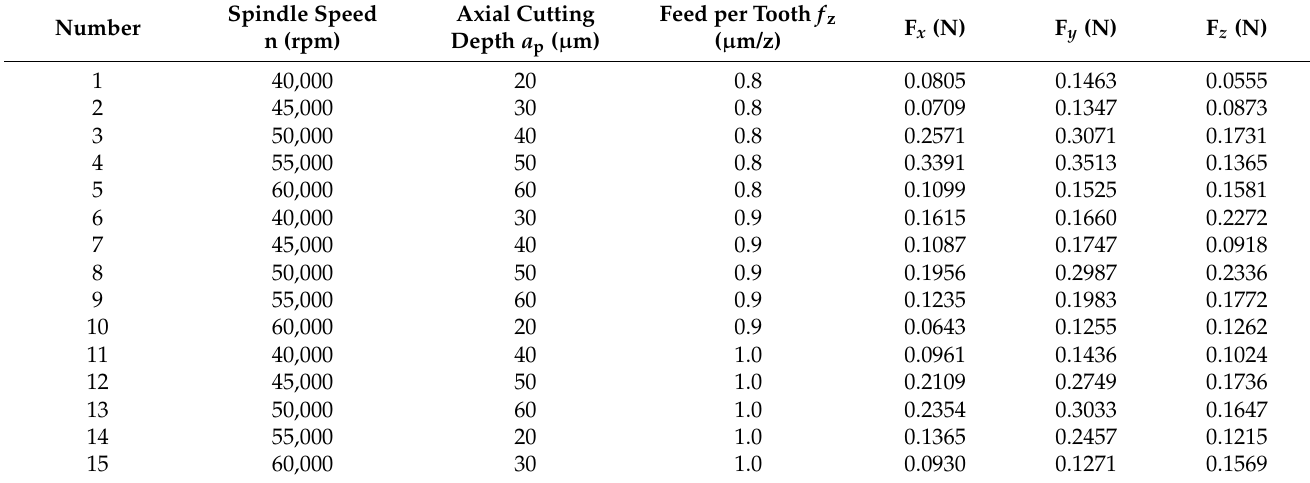
Table 7. Determination of coefficients of micro-milling force model dominated by shear effect.